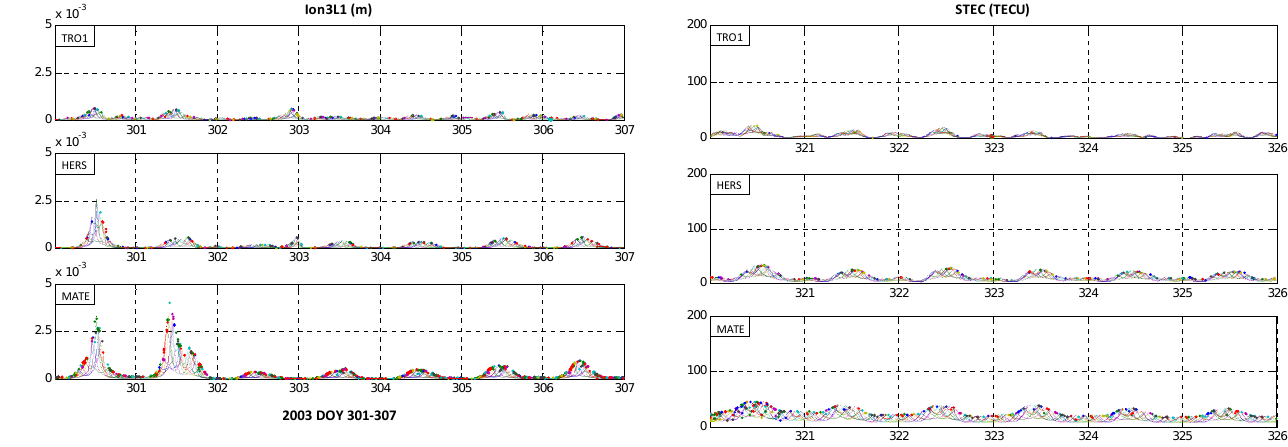
Fig. 10. Ion3 (m) for GPS L1 (Ion3L1) for the observation stations on DOY 301‐307 in 2003. Fig. 11. STEC (TECU) for the three observation stations on 321‐326 in 2006.